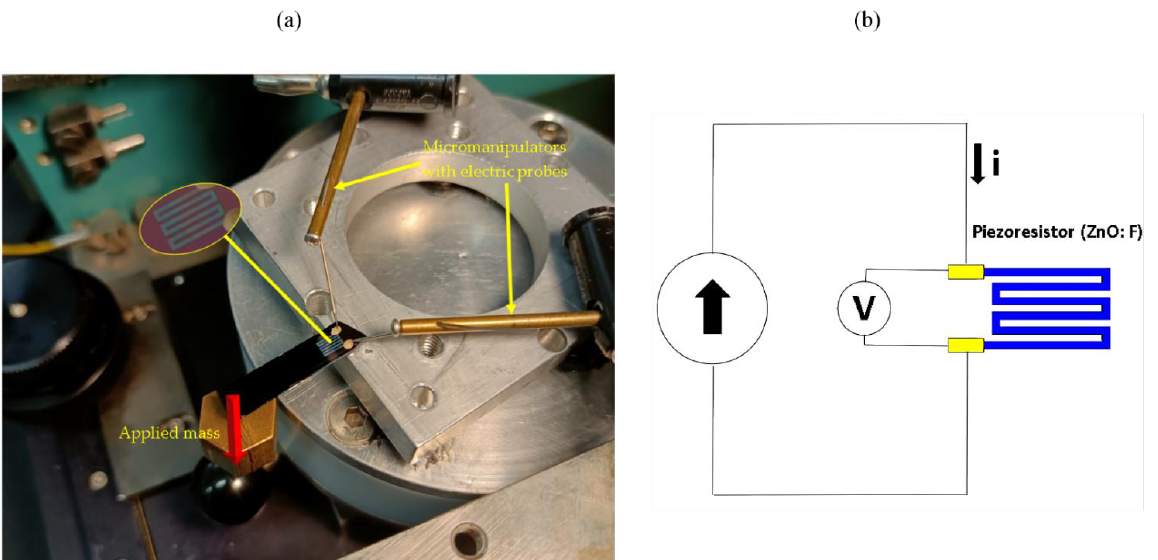
Figure 3. ( a ) Photograph of the cantilever method implemented for the characterization of the ZnO: F thin-film piezoresistor (resistance change measurements under deformation conditions of the piezoresistor were performed at room temperature and isolated from light); ( b ) schematic drawing of the circuit used for the measurement.